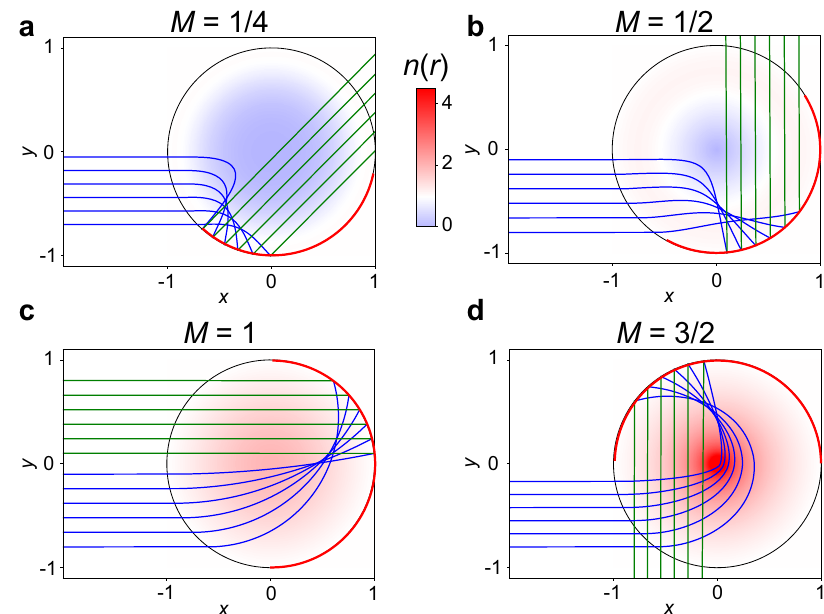
Fig. 2 Double-layer lenses with foci at in fi nity. The Generalized Maxwell Fish Eye pro fi le can be used as a double-layer lens, with one homogeneous layer and foci at in fi nity. We show four examples, with ray turning angle Δ ϕ of π plus a π /4; b π /2; c π ; and d 3 π /2. When M is an odd integer, the lens provides the functionality of an ordinary Eaton lens; when M is an even integer, it acts as an invisible lens where the rays travel in loops in the lens. Note that in Fig. 2 and the following fi gures the mirror coupling into lower waveguide is indicated as a red solid line, and the color of the rays (blue/green) indicates in which waveguide the propagation occurs (upper inhomogeneous index/lower homogeneous index).